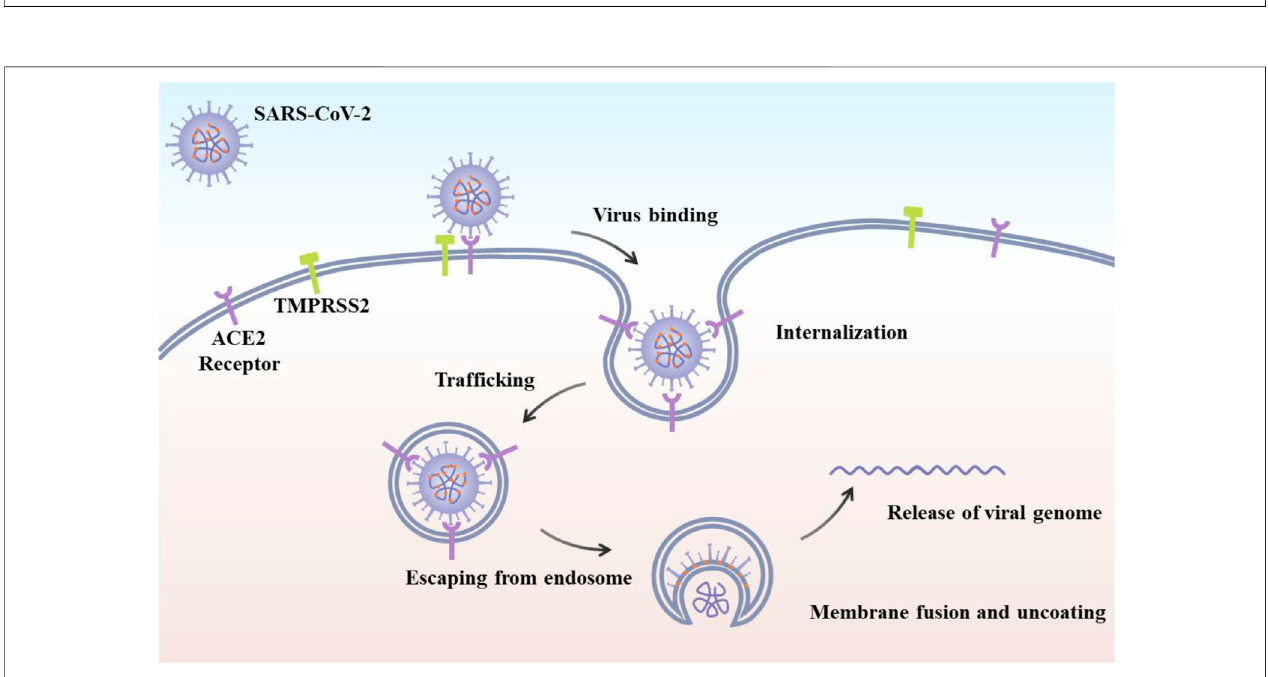
FIGURE 2 | Schematic of SARS-CoV-2 viral life cycle. The initial attachment of SARS-CoV-2 to cells involves speci fi c binding between the viral S glycoprotein and the cellular receptor, ACE2 (Yang et la., 2020).